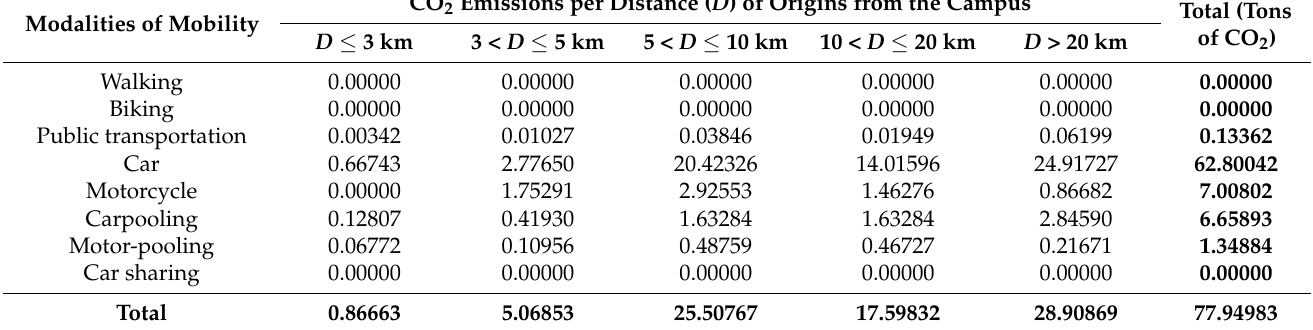
Table 4. SCENARIO 0 —daily energy consumption by zone and mobility modality and by vehicle occupation for all commuters, C zm